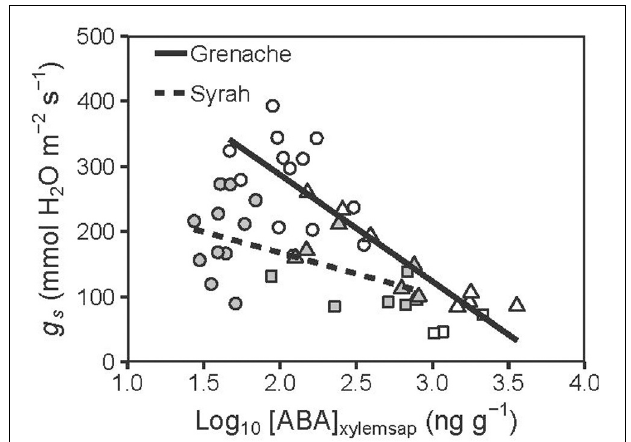
FIGURE 3 | Relationship between [ABA] xylemsap (Log 10 transformed) and g s measured for well-watered (circles), water deficit (triangles), and ABA treated vines (squares) from the cultivars Grenache (open symbols) and Syrah (filled symbols). Significant negative regressions were predicted [Grenache: g s = –163.4 ± 20.9 × log 10 ([ABA] xylem ) + 613.6 ± 53.1; r = –0.86] and Syrah [ g s = –63.9 ± 19.6 × log 10 ([ABA] xylem ) + 295.2 ± 42.7; r = –0.58]. Both linear regressions had significantly different slopes ( P = 0.001) and significantly different intercepts ( P <